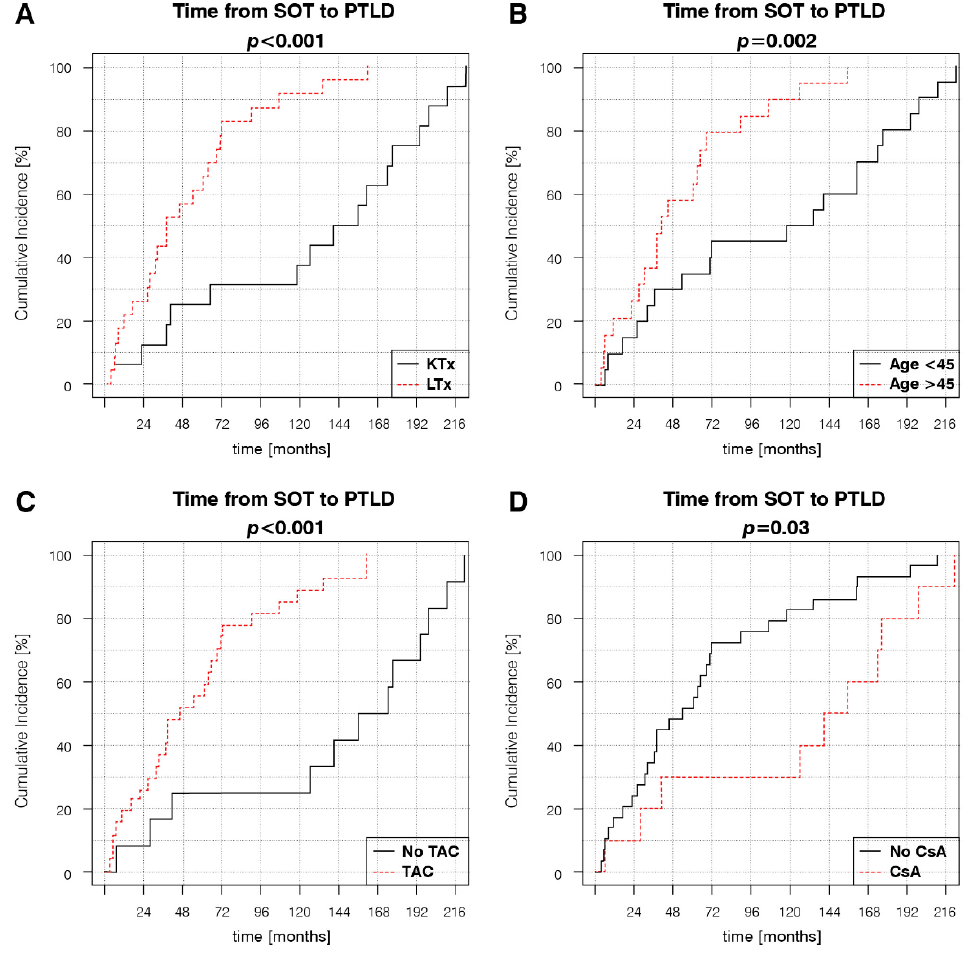
Figure 1. Factors influencing the dynamic of PTLD development in the SOT group: ( A ) organ type, ( B ) age at transplantation, ( C ) use of TAC in the maintenance IS regimen at the time of PTLD diagnosis, and ( D ) use of cyclosporin in maintenance IS at the time of PTLD diagnosis. p -values represent the log-rank analysis of the Kaplan–Meier estimator curves.